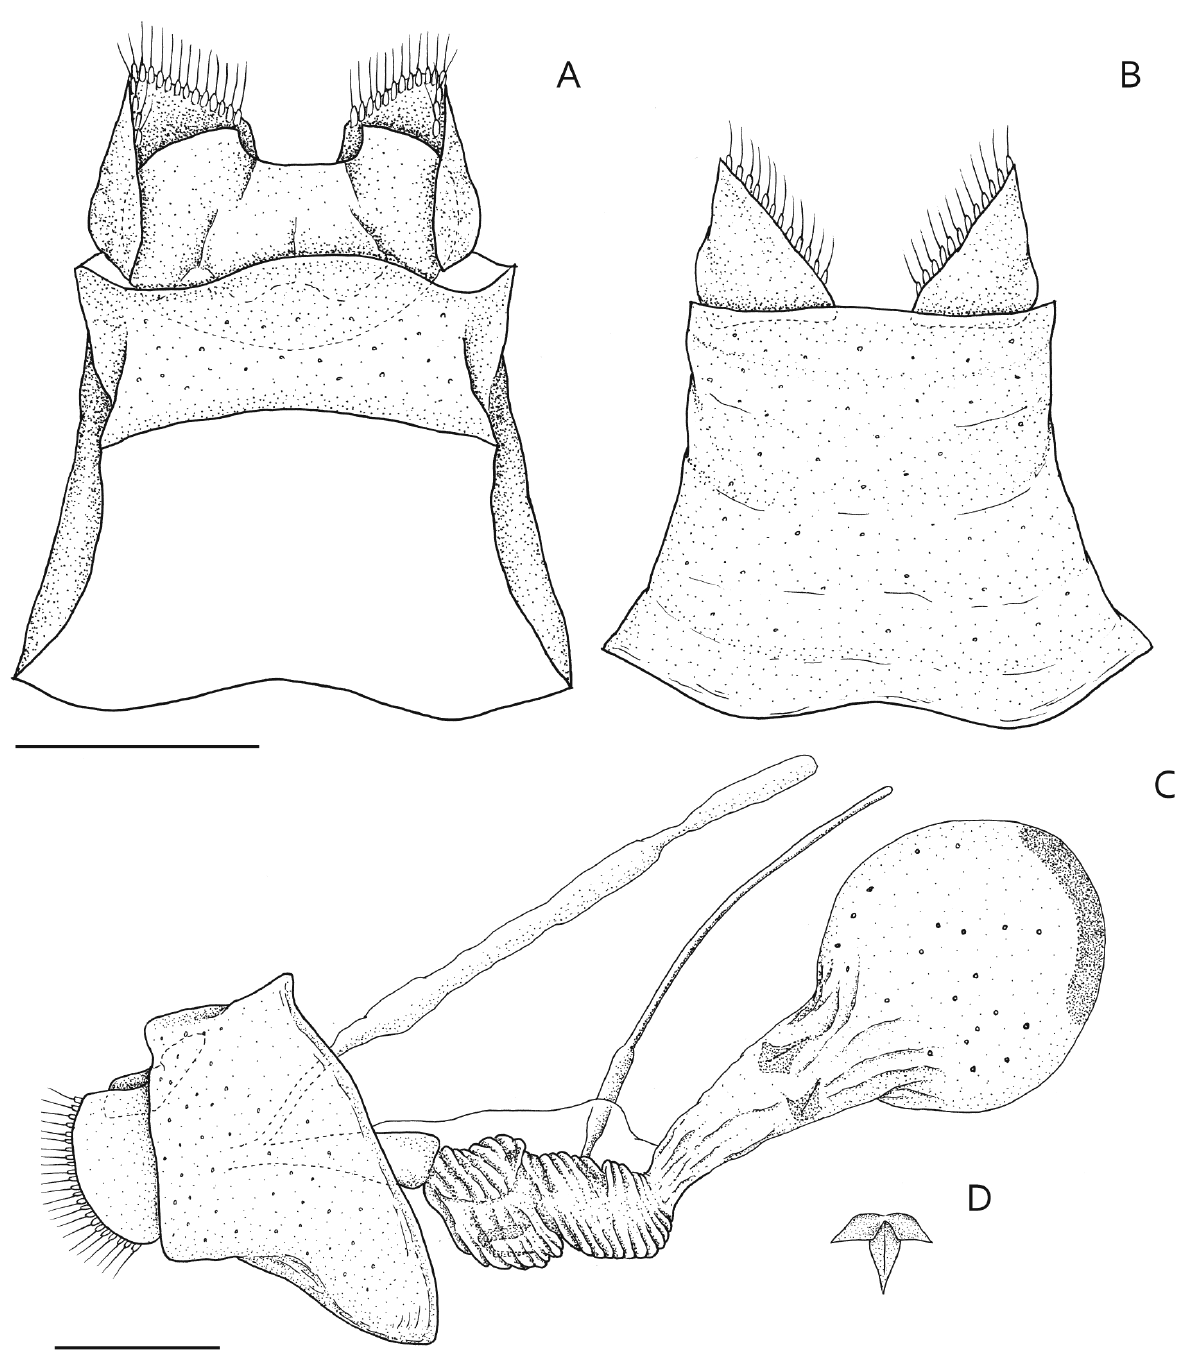
Figure 17. Female genitalia of Issikiomartyria plicata sp. n. [paratype]. A: genitalia capsule, dorsal view; B: ditto, ventral view; C: female genitalia, lateral view; D: genital sclerite. Scale bars: 0.2